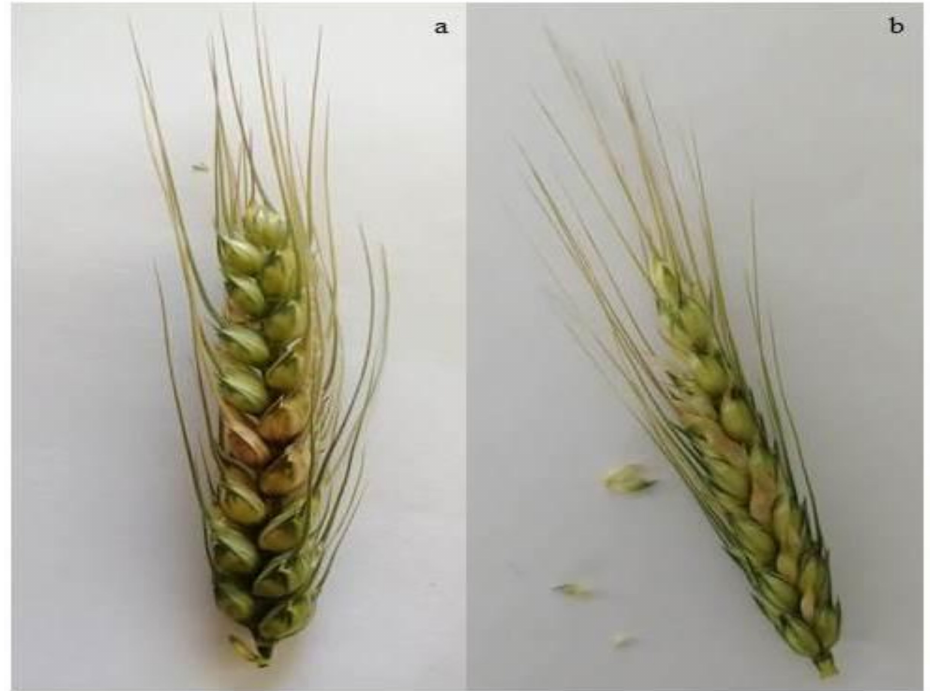
Figure 3. Heads of Vulkan at 26 DAF at Osijek ( a ) and Tovarnik ( b